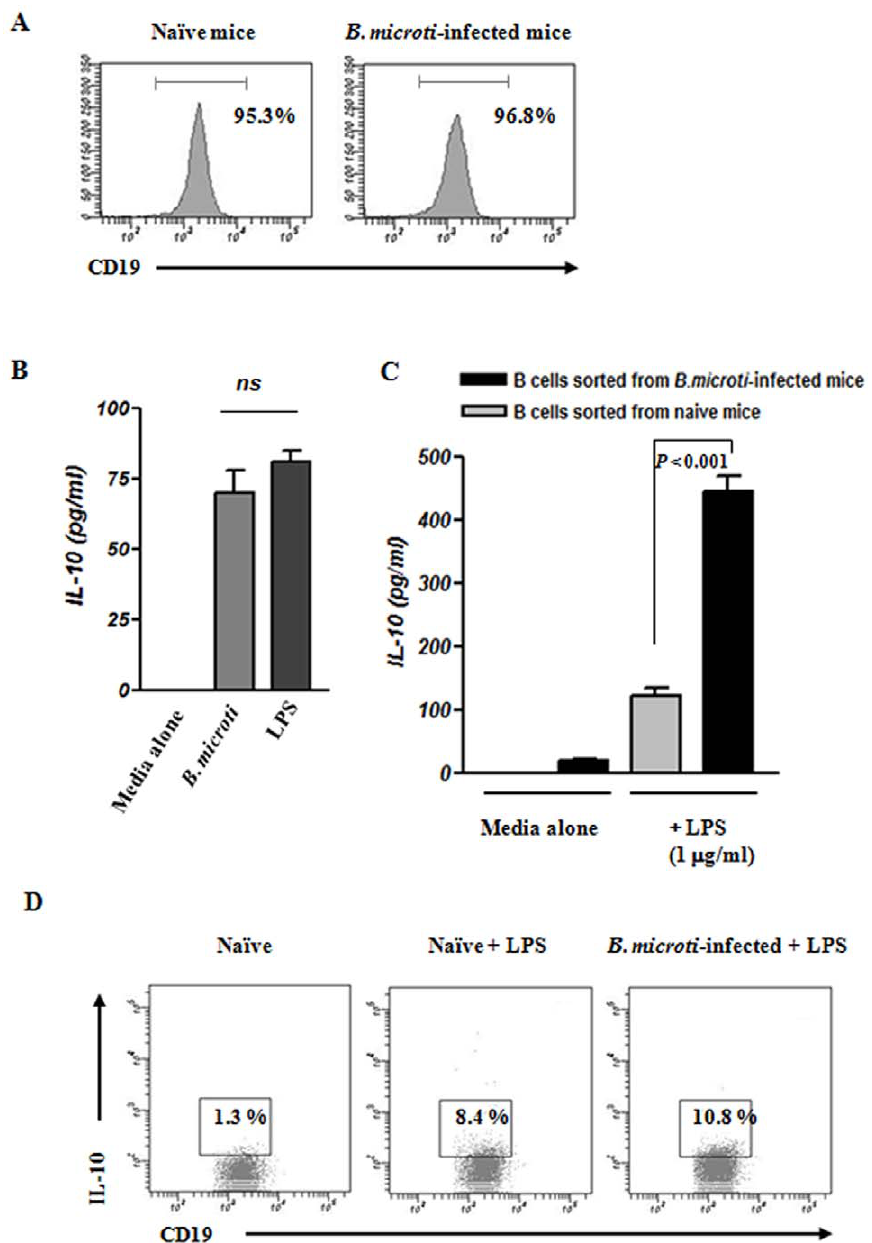
Figure 4. B cells secrete IL-10 in response to B.microti stimulation invitro . Splenic B cells were purified from naı¨ve or B. microti -infected mice by MACS as described in the Materials and methods (A) Representative histograms showing the purities of splenic CD19 + B cells isolated from either naı¨ve (left) or B. microti -infected (right) mice. The purity of isolated B cells was . 95% as assessed by flow cytometric analysis. (B) B cells sorted from naı¨ve mice were stimulated with media alone, B microti , or LPS (1 m g/ml) for 24 h before the level of IL-10 in culture supernatants was determined by ELISA. (C) B cells isolated from either naı¨ve mice or B. microti -infected mice were cultured with LPS for 5 h before the level of IL-10 in culture supernatants was measured by ELISA. (D) B cells were purified from naı¨ve or B. microti -infected mice cultured with LPS for 5 h. The cells were then stained with anti-CD19 mAb, permeabilized, and stained intracellularly using anti-IL-10 mAb. Cytoplasmic IL-10 production was determined by flow cytometric analysis. Percentages indicate IL-10-producing cells among total CD19 + B cells. These in vitro experiments were repeated at least three times.